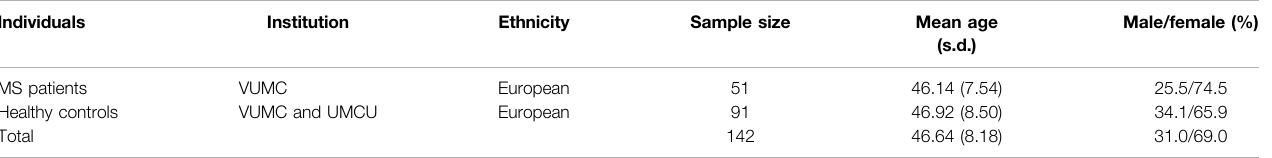
TABLE 1 | Summary of the 142 individuals studied in this